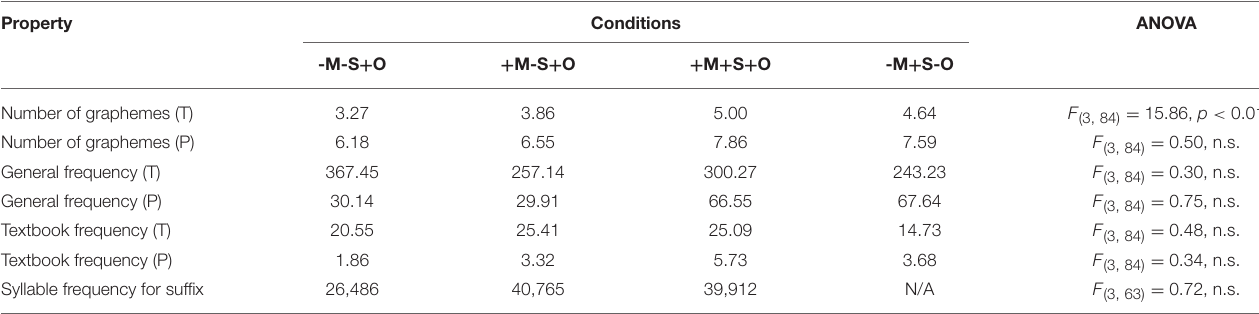
TABLE 2 | Stimulus characteristics for items across the four conditions. Property